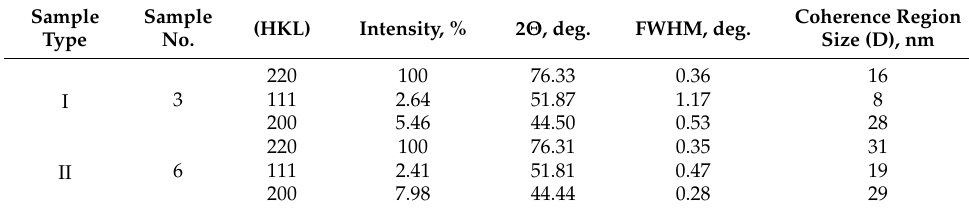
Table 3. The main parameters of the XRD spectra for the Ni NWs in MPAA for I and II sample types. Sample Sample Type